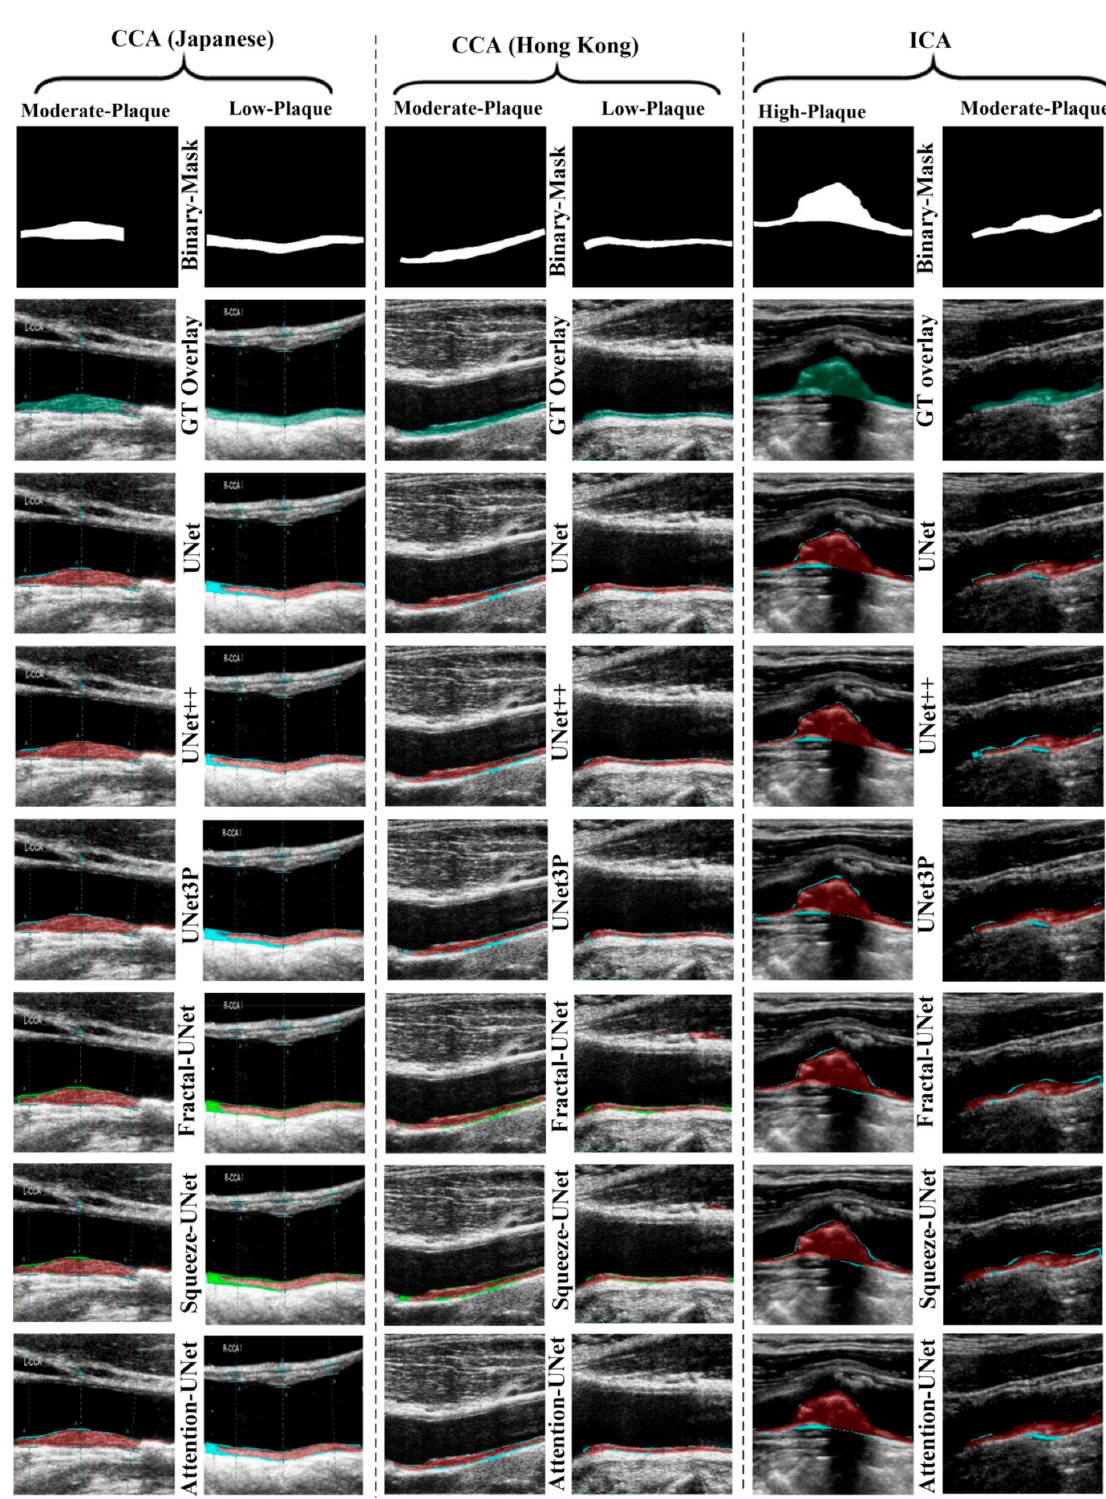
Figure 8. Visual results of the segmentation of Japanese, Hong Kong and UK (ICA) databases, performed by UNet, UNet++, UNet3P, and Attention-UNet models. The attention mechanism states that the attention blocks modify the deep features by applying the attention weights. The same can be seen visually in some critical images shown in Figure 9, which are not successfully segmented using other